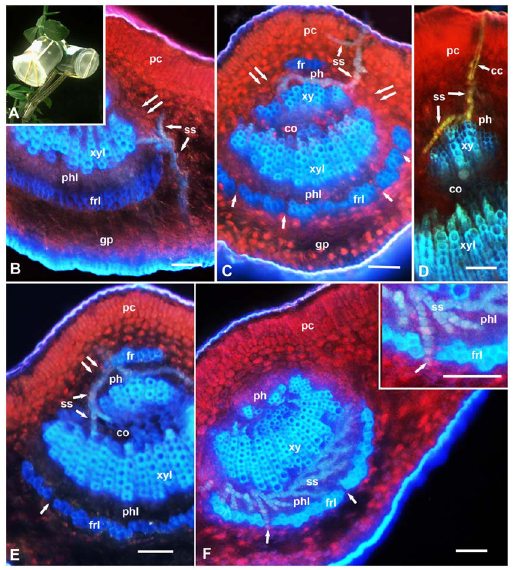
Figure 1. A, Clip cages used for confining adults of D. citri on x Citroncirus leaves. B–F, Epifluorescence micrographs showing stylet sheaths (ss) of D. citri in cross sections of the midrib in leaves of the relatively susceptible (Troyer-1459) plants. In B–F, the upper (adaxial) leaf side is up, and the lower (abaxial) side is down; unlabeled single arrows indicate smaller gaps in the fibrous ring; double arrows indicate wider gaps in this ring at the sides of the vascular bundle. Abbreviations: cc, central canal in the stylet sheath; co, core cells; fr, upper fibrous ring; frl, lower fibrous ring; gp, ground/spongy parenchyma; pc, palisade parenchyma cells; ph, upper phloem; phl, lower phloem; ss, stylet sheath; xy, upper xylem; xyl, lower xylem. Scale bars=50 m m.